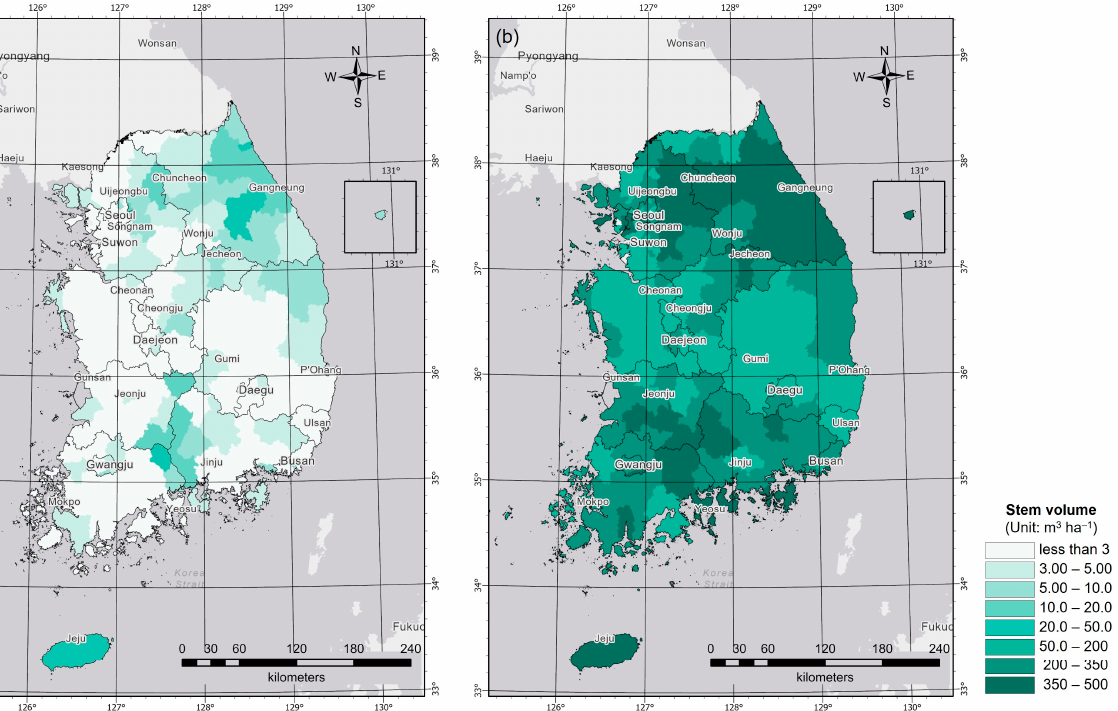
Figure 1. Forest maps of stem volume ( a ) before (in 1973) and ( b ) after the national forest rehabilitation plan (in 2019; data source: Korea Forest Service [24]; basemap sources: Esri, Redlands, CA, USA; HERE, Eindhoven, Netherlands; Garmin, Switzerland; © OpenStreetMap contributors; and the GIS User Community).